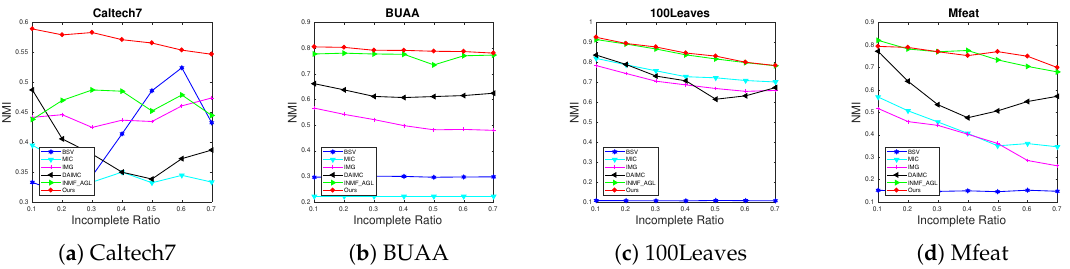
Figure 3. NMI results with different incomplete ratios on four incomplete